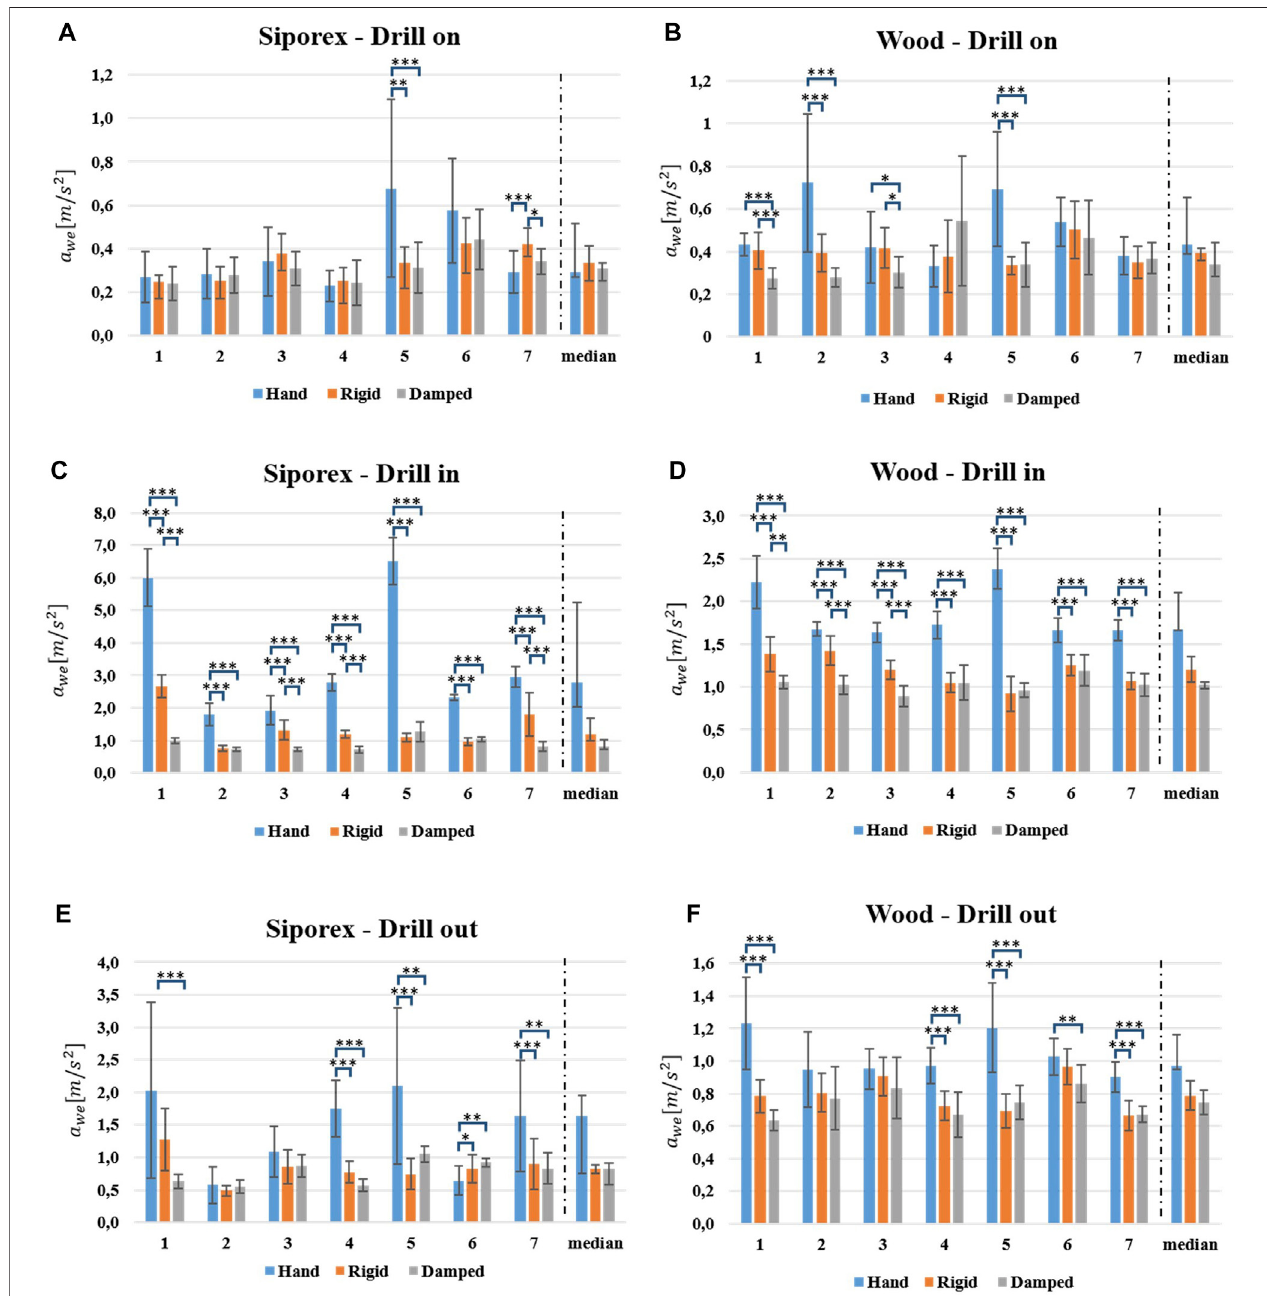
FIGURE6| The a hand hv foreachsubjectandthemedianvaluesamongthesubjects(separatedbythedottedlineineachplot)arereportedforboththeSIPOREXand the wood experiments. (A,C,E) Acceleration values for the SIPOREX drill on , drilling in , and drilling out phases. Plots (B,D,F) show acceleration values of the same phases for drilling wood. Statistical differences legend: * (cid:2) p < 0 . 05, ** (cid:2) p < 0 . 01, *** (cid:2) p < 0 . 001. No statistical investigation has been conducted for median values.